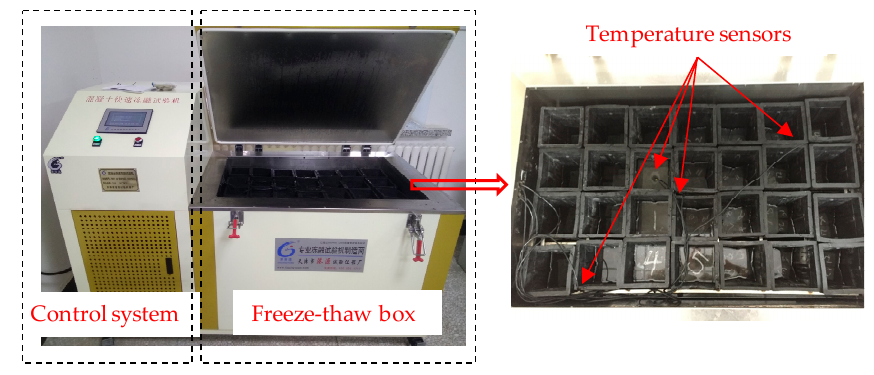
Figure 3. Freeze – thaw cycle test. Figure 3. Freeze–thaw cycle Table 6. Freeze – thaw cycle test grouping.